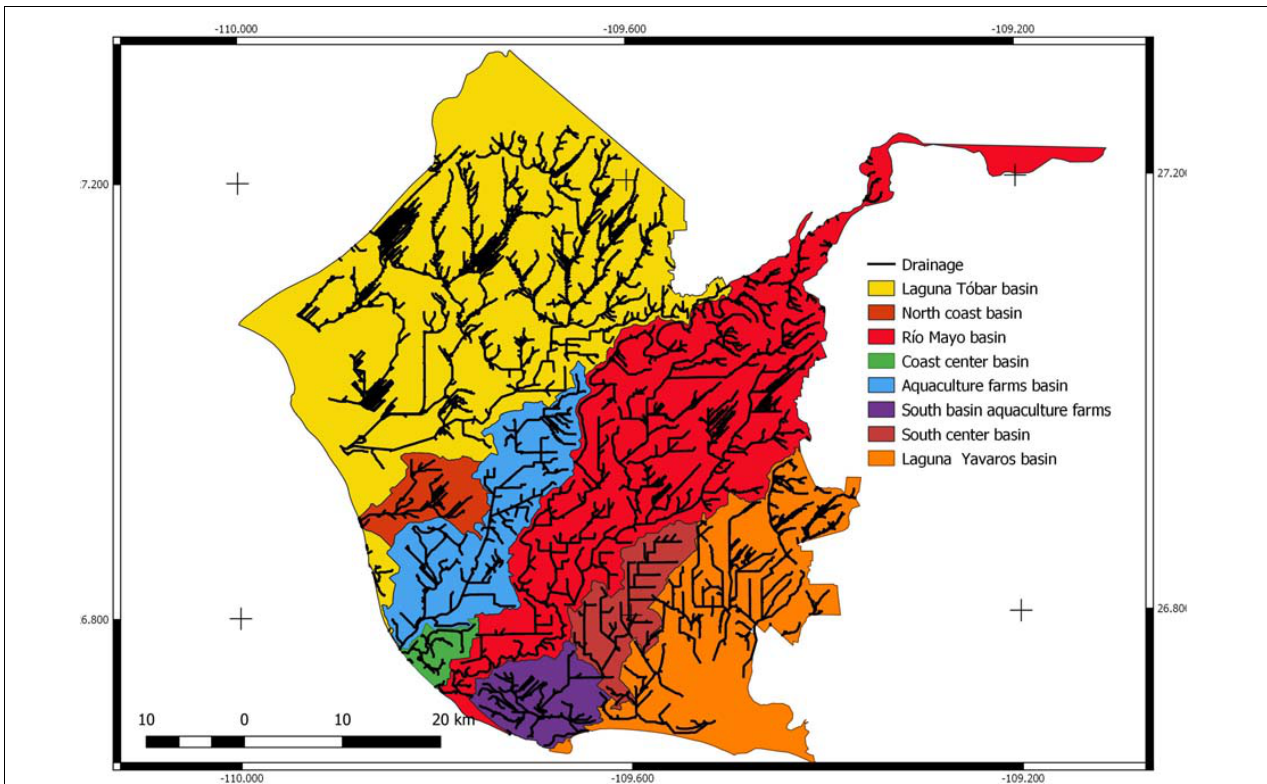
FIGURE 3 | Drainage lines calculated in black along with the main points of entry of nutrients, superimposed with the eight hydrological basins determined for the region of the Irrigation District of the Río Mayo. On the upper right corner, a Landsat 543 band combination is